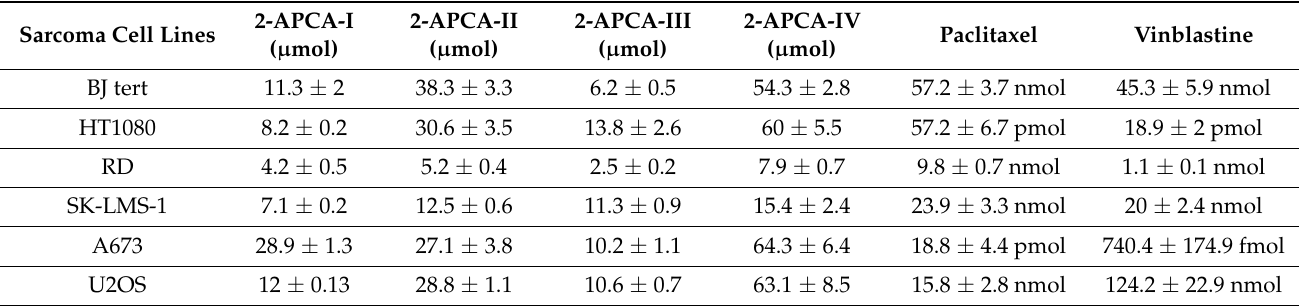
Table 1. IC50 values for 2-amino-pyrrole-carboxamides (2-APCAs) (I-IV), paclitaxel, and vinblastine for non-transformed fibroblasts (BJ tert) and soft tissue sarcoma cell lines.